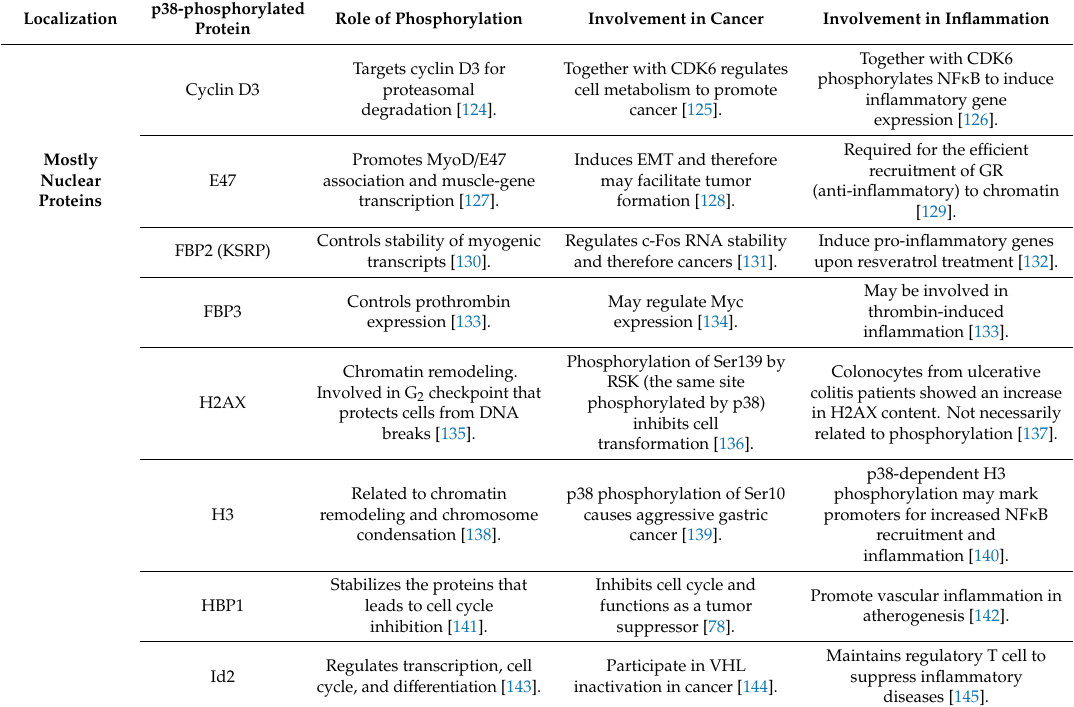
Table 1. Nuclear substrates of p38 α / β and their role in cancer and inflammation. More than 120 substrates of p38 α / β were found in several reviews [27,43,86–89], and the translocation of each one of them was inspected in various databases. Substrates with constant ( > 80%) nuclear localization in all cell lines described are shown under “Mostly Nuclear Proteins”, while proteins that are mostly nuclear in resting cells but are exported to the cytoplasm after stimulation are shown under “Nuclear Export”. The role of the p38 α / β phosphorylation, as well as their general involvement in cancer or inflammation (independent of the phosphorylation in the nucleus) is described for each nuclear substrate. ND—not